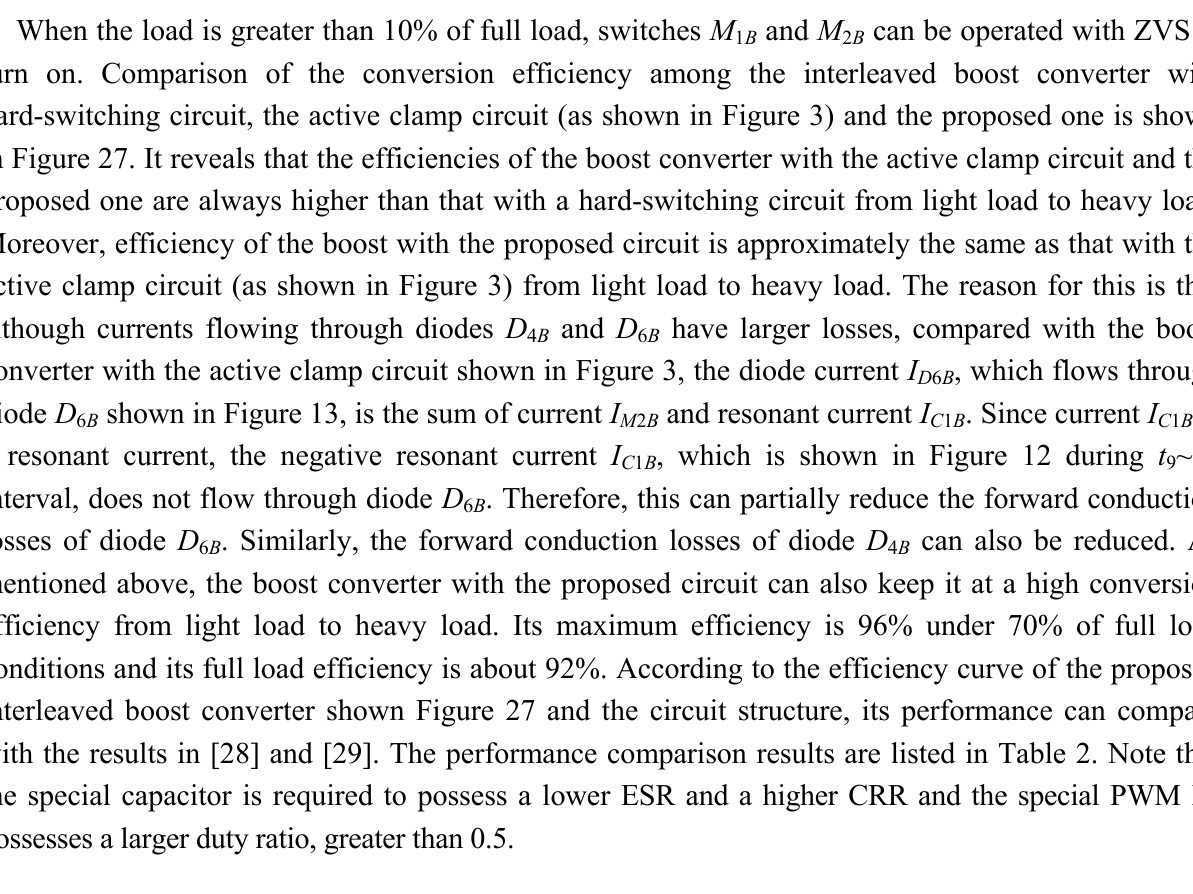
Table 2. Performance comparison of interleaved high step-up